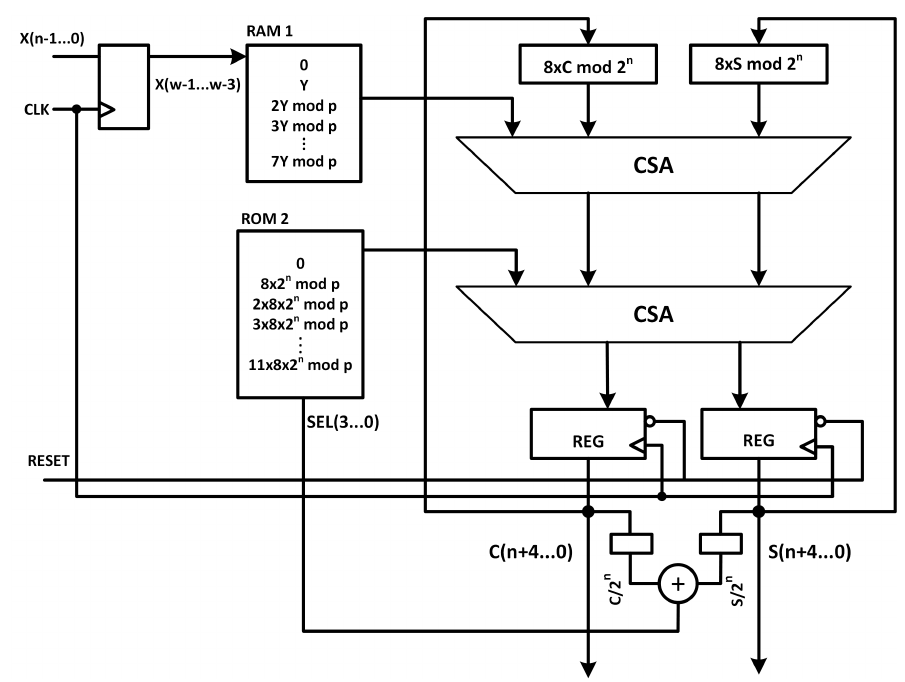
Figure 6. Radix-8 Interleaved modular multiplication unit.